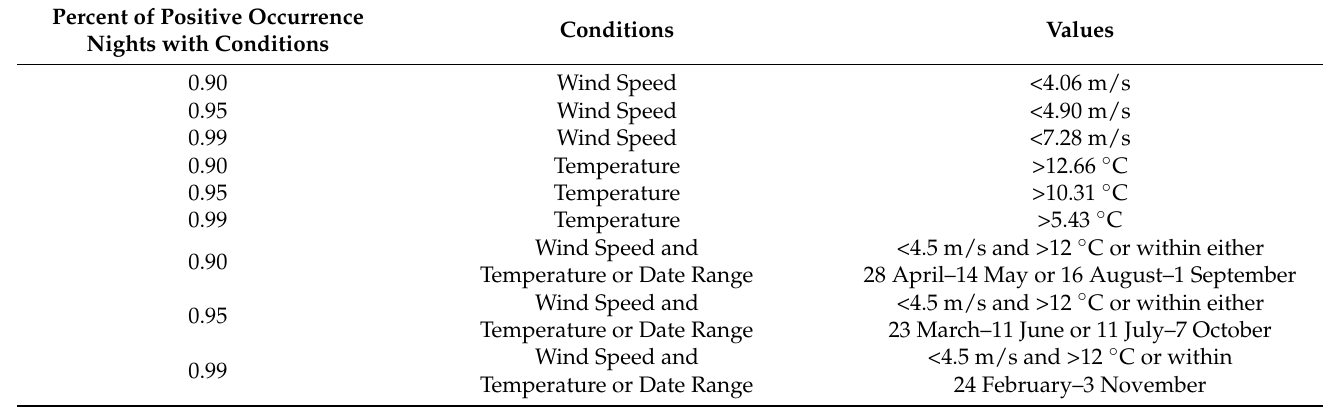
Table 2. The 90%, 95%, and 99% quantiles representing the proportion of nights with tree bat occurrence under certain conditions of wind speed, temperature, and/ or date ranges using acoustic data collected on the Eastern Shore of Virginia, USA, 2012–2019.